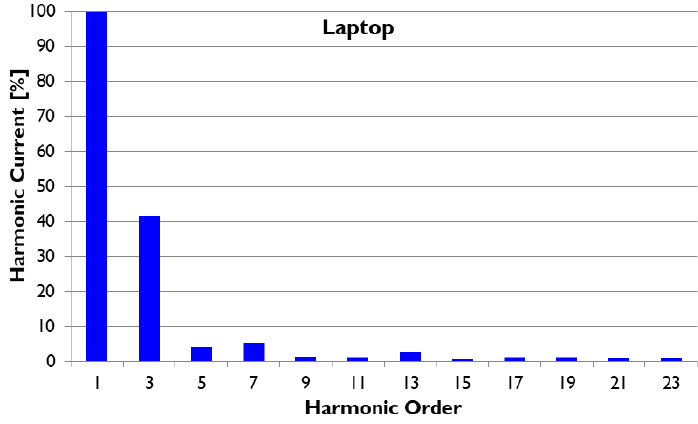
Figure 6. Current spectrum of the laptop.